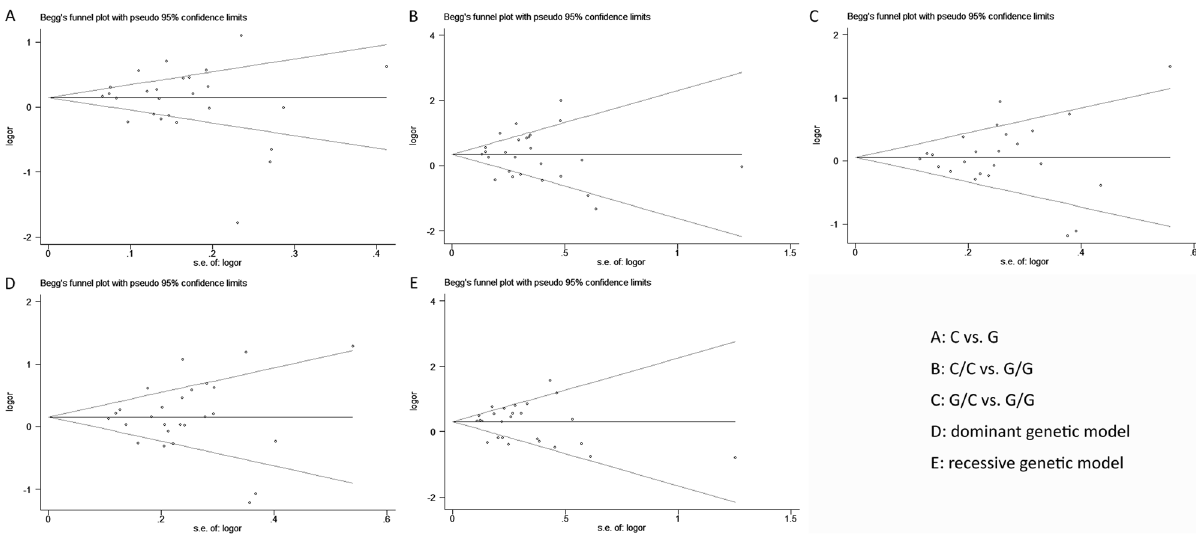
Figure 5. Begg’s funnel plot of the survivin rs9904341 and tumor risk in different contrast models. A: C vs. G, B: C/C vs. G/G, C: G/C vs. G/ G, D: dominant genetic model (C/C + G/C vs. G/G), and E: recessive genetic model (C/C vs. G/C + G/G).